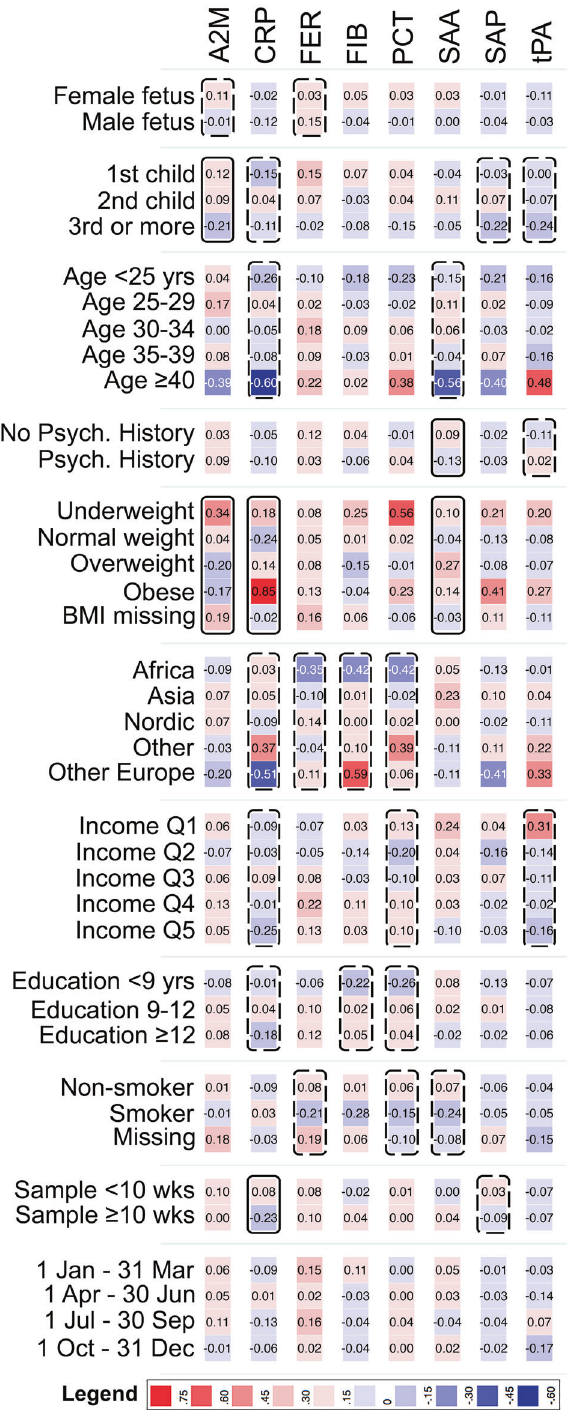
Fig. 1 Heat map showing the mean maternal APP z-score by categories of the covariates, among mothers to 429 unaffected individuals in the cohort. Solid boxes indicate that the APP is associated with the covariate at p < 0.05. Dashed boxes indicate that the APP is associated with the covariate at p < 0.20. Abbreviations: A2M α -2 macroglobulin, CRP C-reactive protein, FER ferritin, FIB fi brinogen, PCT procalcitonin, SAA serum amyloid A, SAP serum amyloid P, tPA tissue plasminogen activator, Psych Psychiatric, BMI body mass index, Income Q income